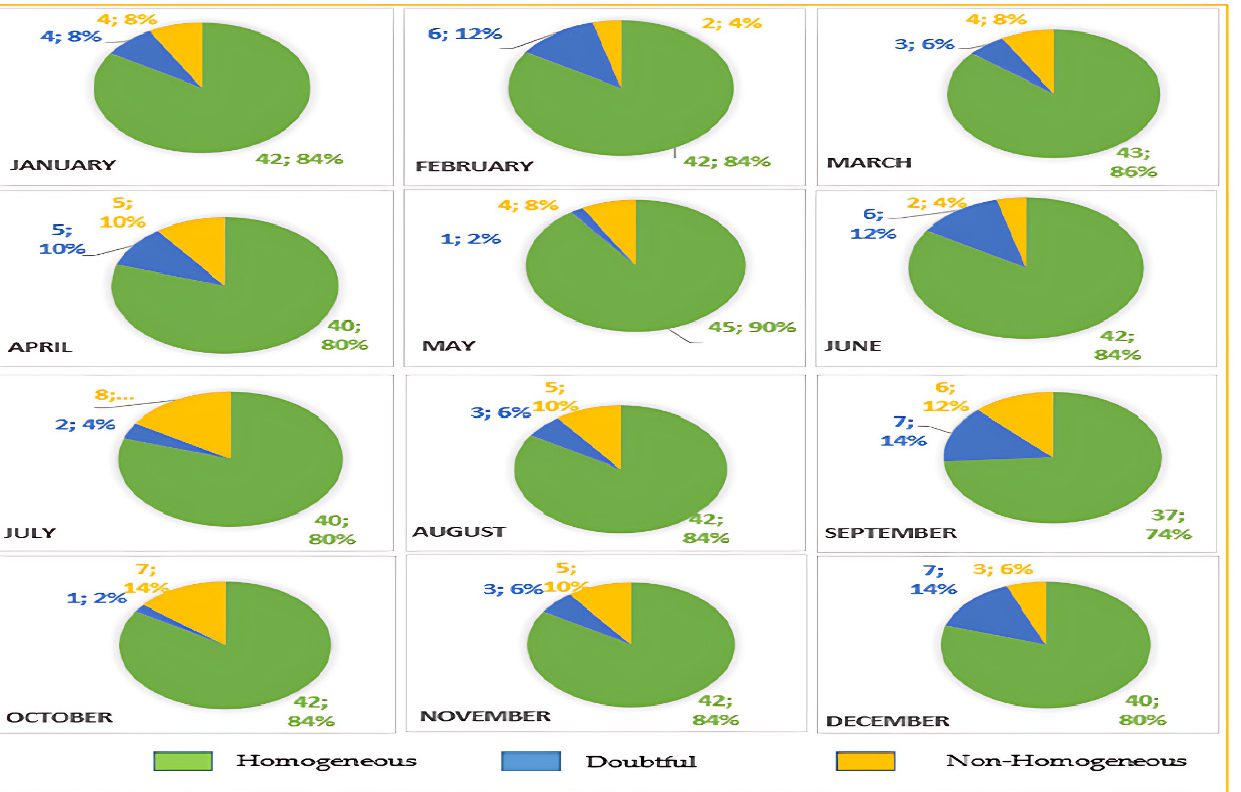
Figure 3. Monthly Homogeneity Test.